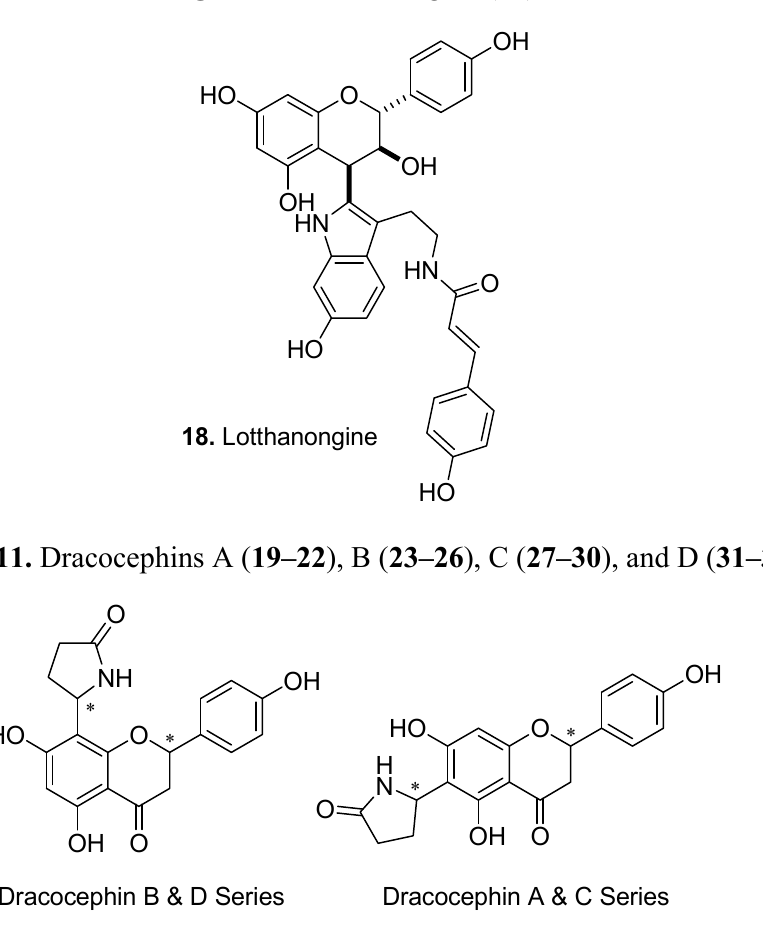
Figure 10. Lotthanongine ( 18